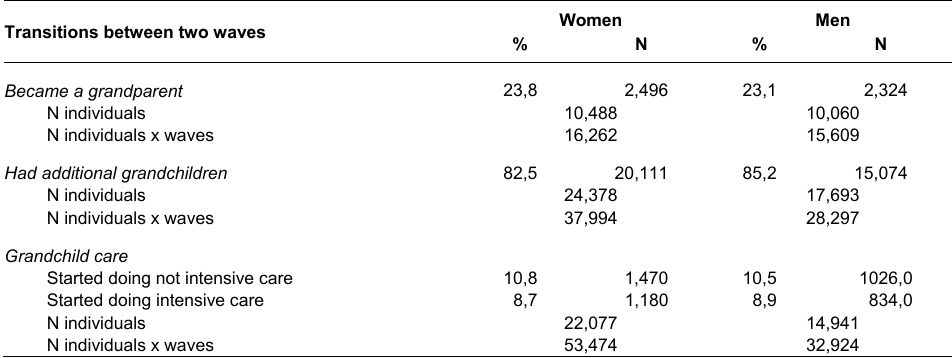
Descriptive statistics on some transitions observed for the explanatory